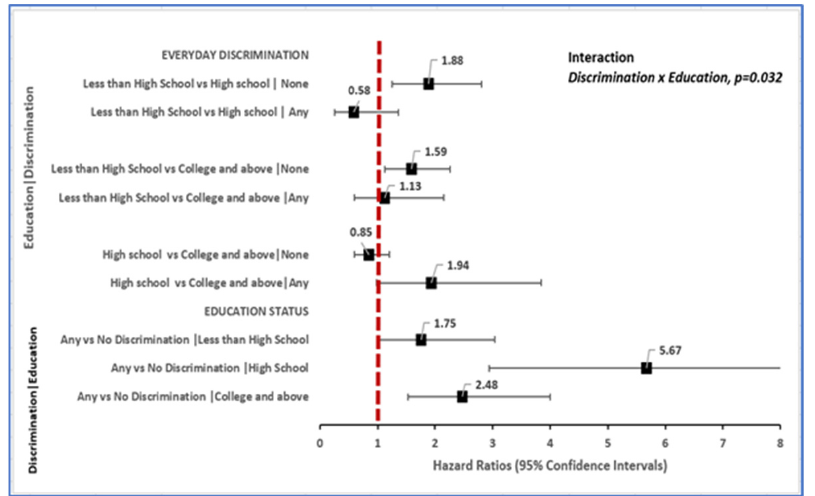
Figure 5. Discrimination-related differences in risk of incident dementia within strata of education.